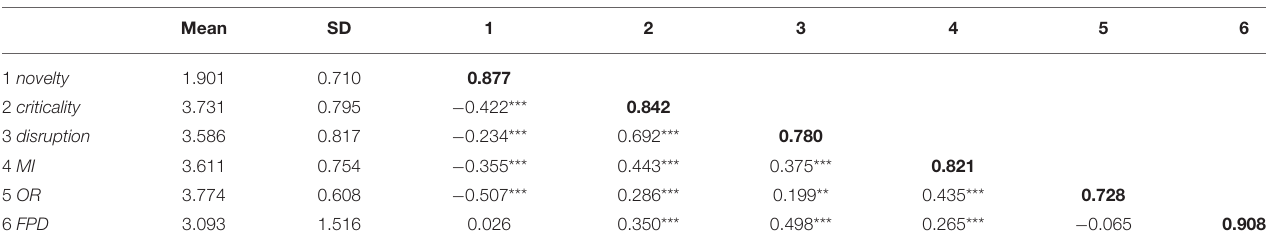
TABLE 4 | Means, standard deviations and correlations coefficients ( N = 201).